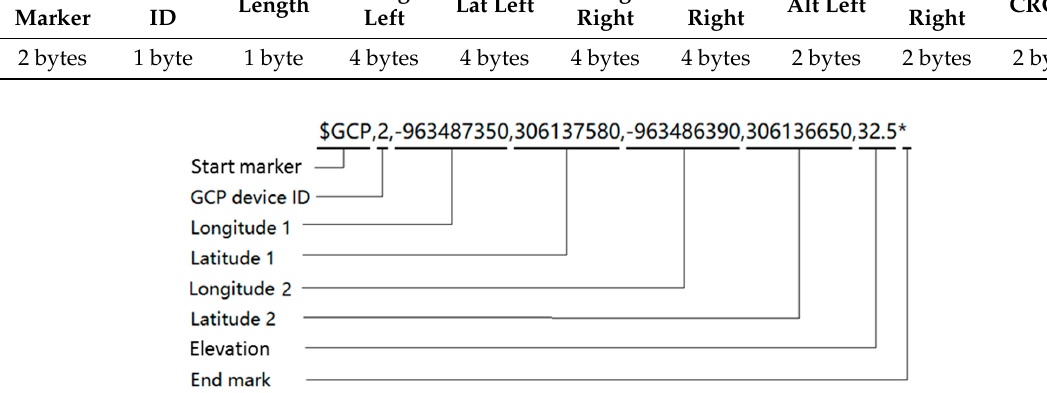
Table 1. Format of the GCP query instruction. Table 2. Format of the global positioning system (GPS) data package of the requested GCP.